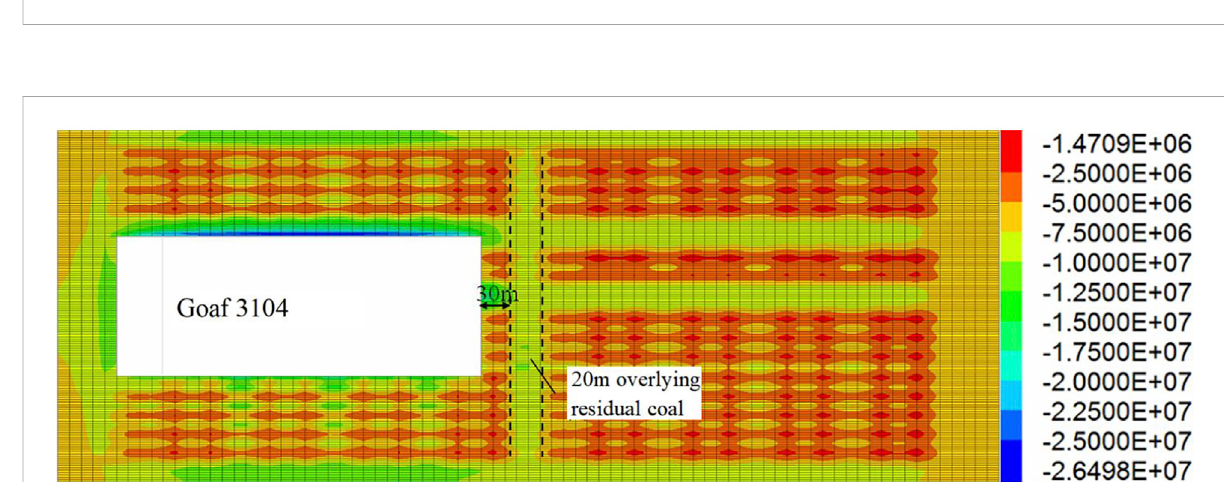
FIGURE 21 Cloud diagram of vertical stress distribution at 40m of overlying residual coal pillar (Pa).